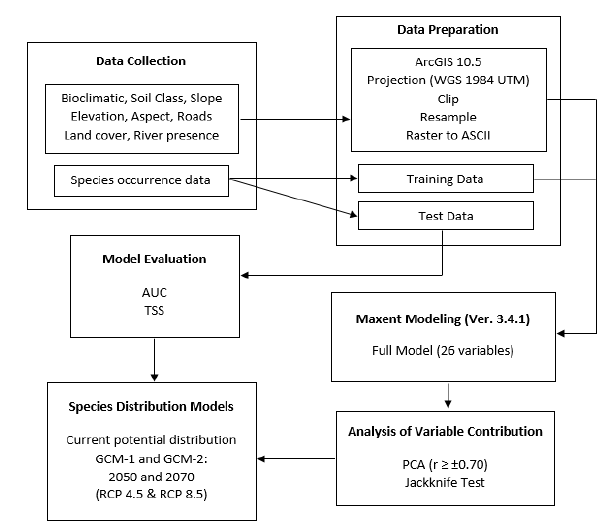
Figure 1. The research flow diagram.